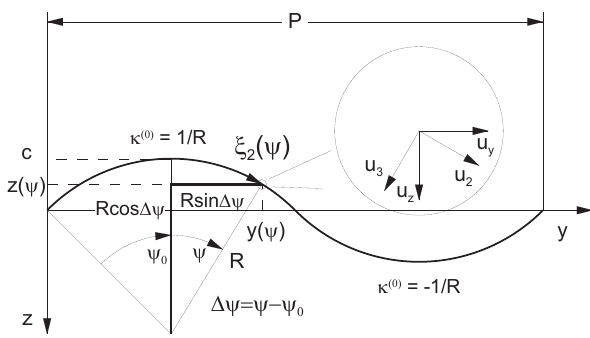
Figure 1: Unit-cell geometry and coordinate conventions